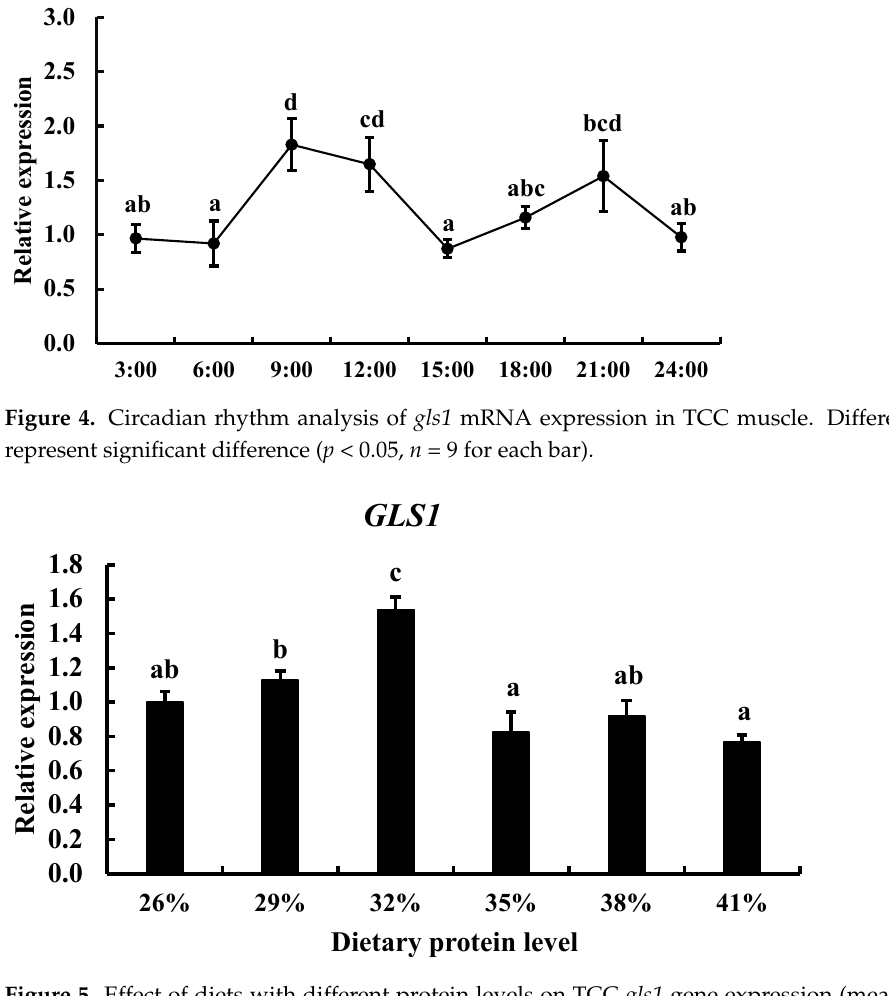
Figure 5. Effect of diets with different protein levels on TCC gls1 gene expression (mean ± SE of relative expression; n = 9). Different letters represent significant difference ( p < 0.05).